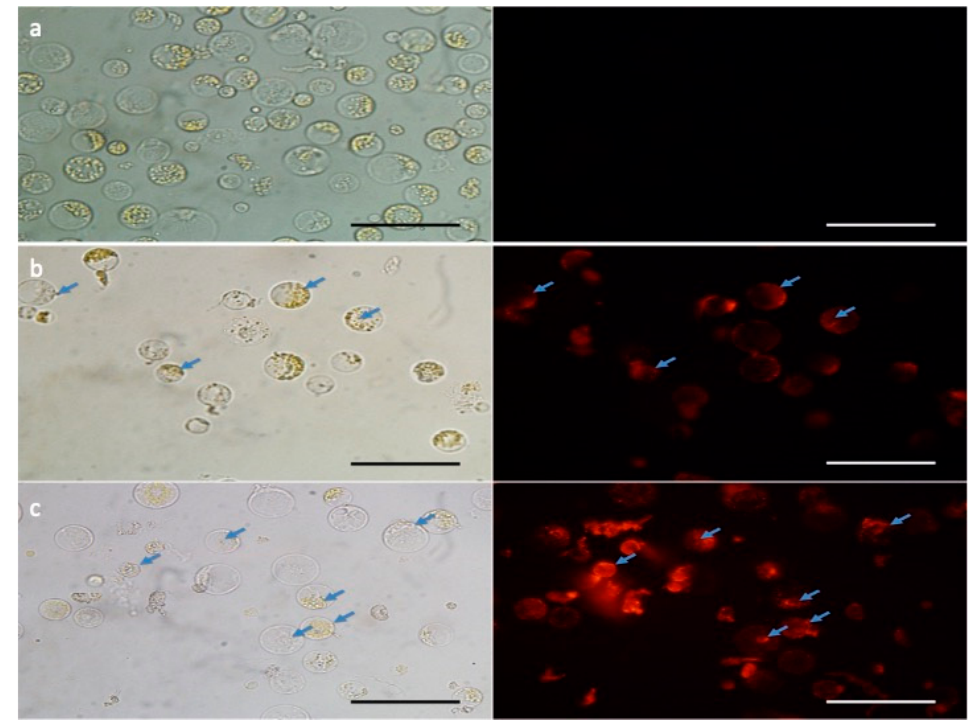
Figure 3. Microscope photographs of maize protoplast cells transfected with polyethylene glycol (PEG)-mediated CRSIPR-Cas9 RNP. The RNP containing the ATTO550-conjugated trans-activating crispr RNA (tracrRNA) was transfected into maize protoplasts and cells were monitored under fluorescent microscopy to check the transfection efficiency. Comparing to the cells without CRISPR-Cas9 delivery ( a —control sample), the red fluorescent signal was detected in CRISPR-Cas9 treated samples ( b and c —right). Photographs were taken with white light (left side) and fluorescent light (right side). Blue arrows indicate the internalization of the RNP complex. Scale bars: 100 μ m.